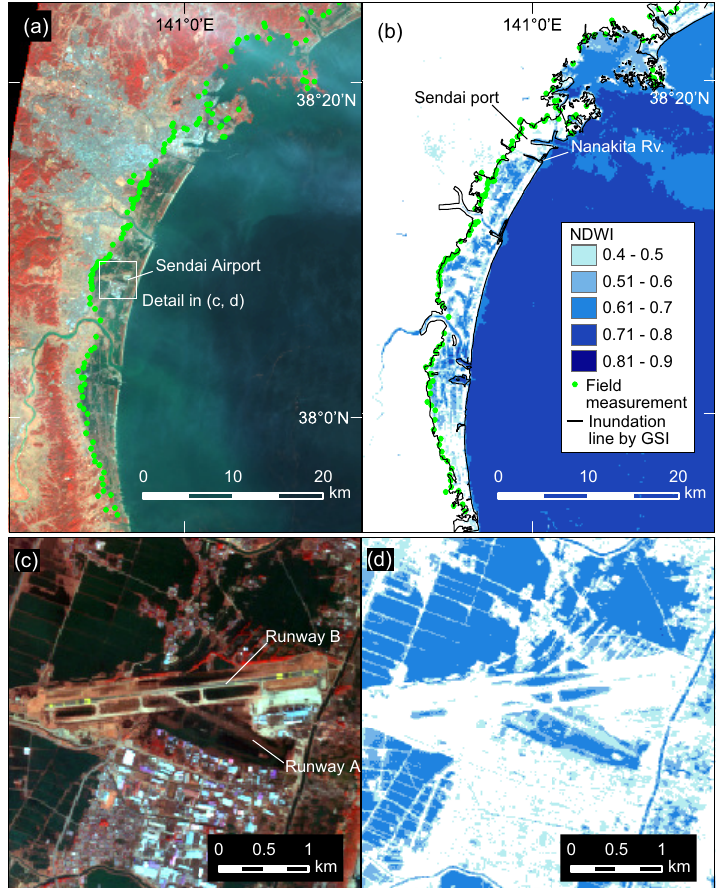
Figure 3. Tsunami inundation mapping results from ALOS/AVNIR-2 [10]. ( a ) False color composite of the 14 March 2011 image with field measurement of the tsunami inundation extent (green dots). ( b ) Result of the extraction of the tsunami inundation zone from 14 March image. The threshold value of NDWI = 0.4 was applied. The black solid line is the visually-interpreted inundation line from the aerial photos by Geospatial Information Authority of Japan (GSI). ( c ) Detailed image of Sendai airport. Runway A (1150 m) was totally flooded, and Runway B (3000 m) was almost dry at the time of acquisition. ( d ) NDWI-based extraction at Sendai